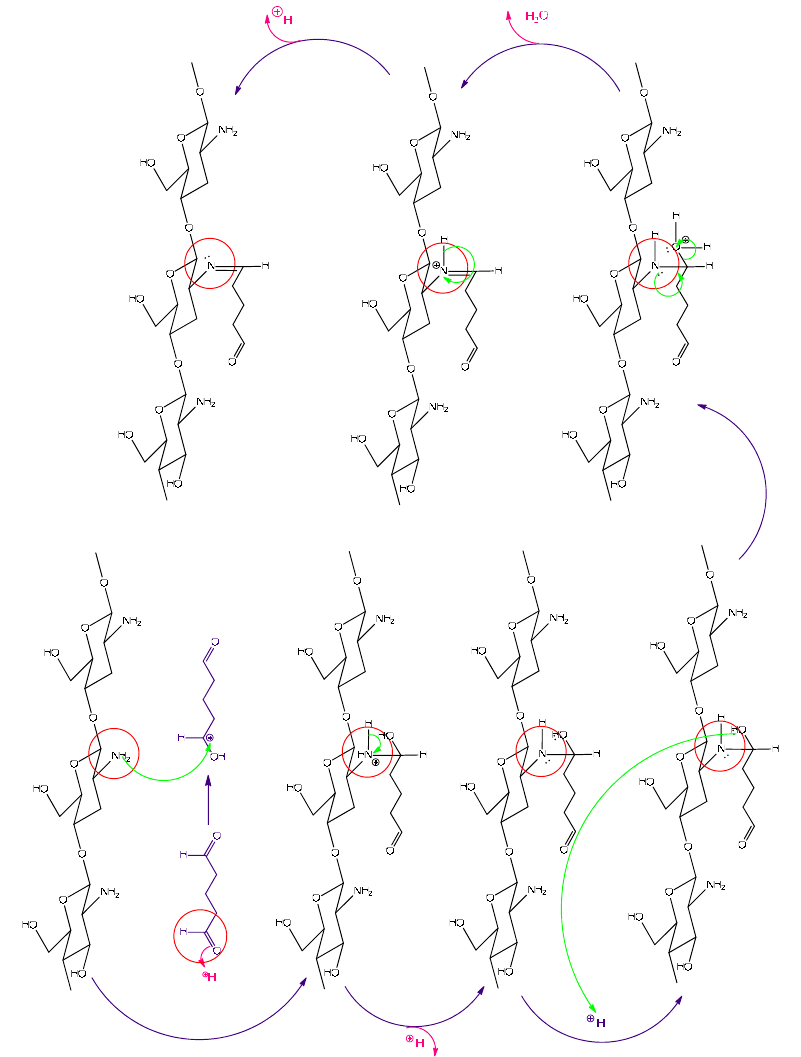
Fig. 5. Antibacterial studies a) CHX, b) Fig.5.